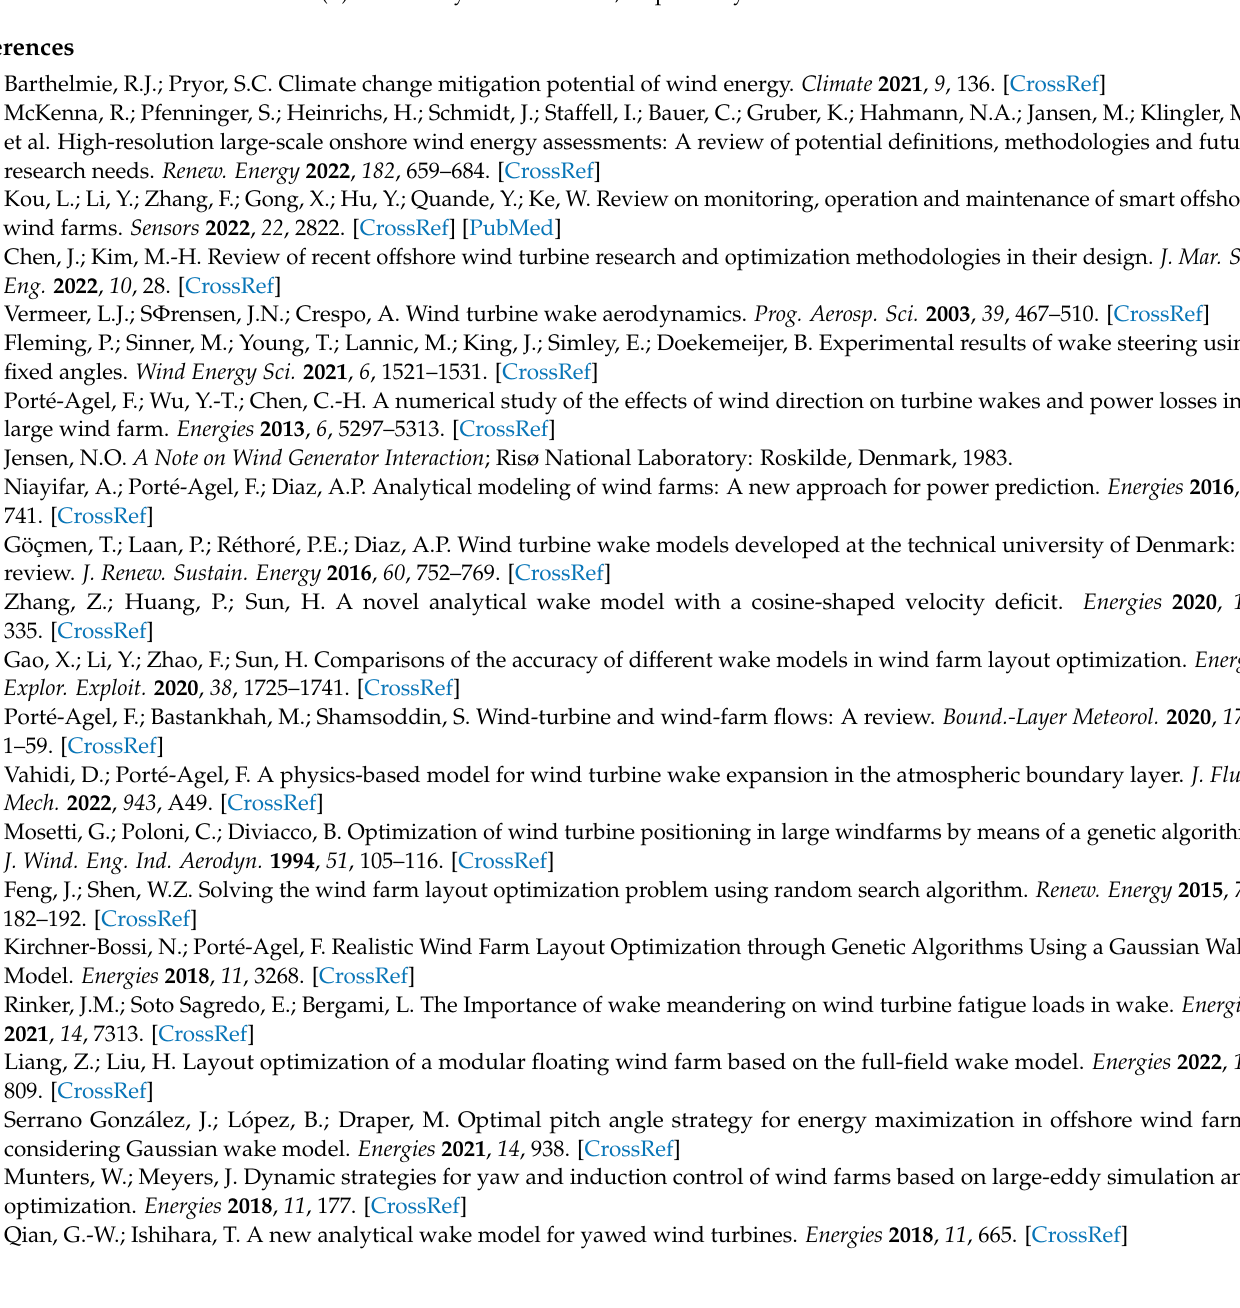
Figure A6. CFD results of the time history of the angular velocity of each rotor in ( a ) parallel layout and ( b ) tandem layouts of 4 rotors, respectively.